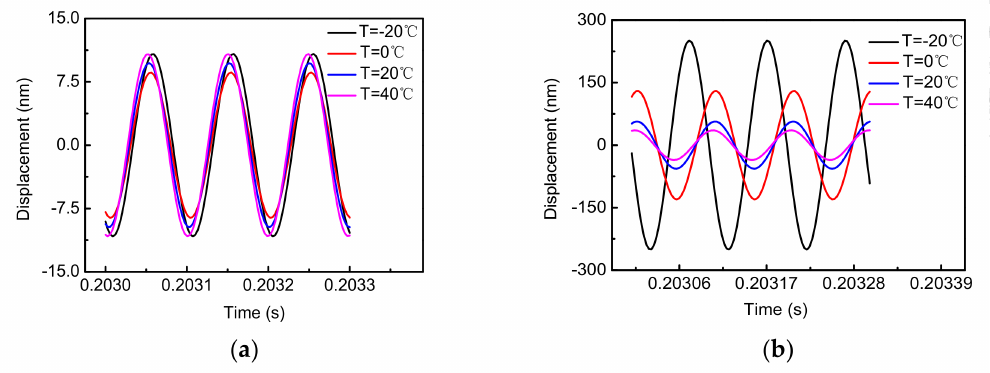
Figure 6. Displacements of the capacitive MEMS gyroscopes PSPICE model at different temperatures with the same excitation ( f d = 10.157 kHz, A = 5 V): ( a ) drive-axis displacement ( b ) sense-axis